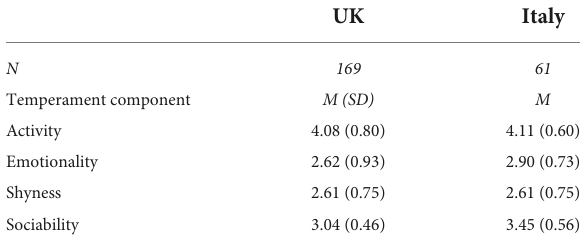
TABLE 10 Emotionality activity sociability–temperament subscale (EAS-T) component